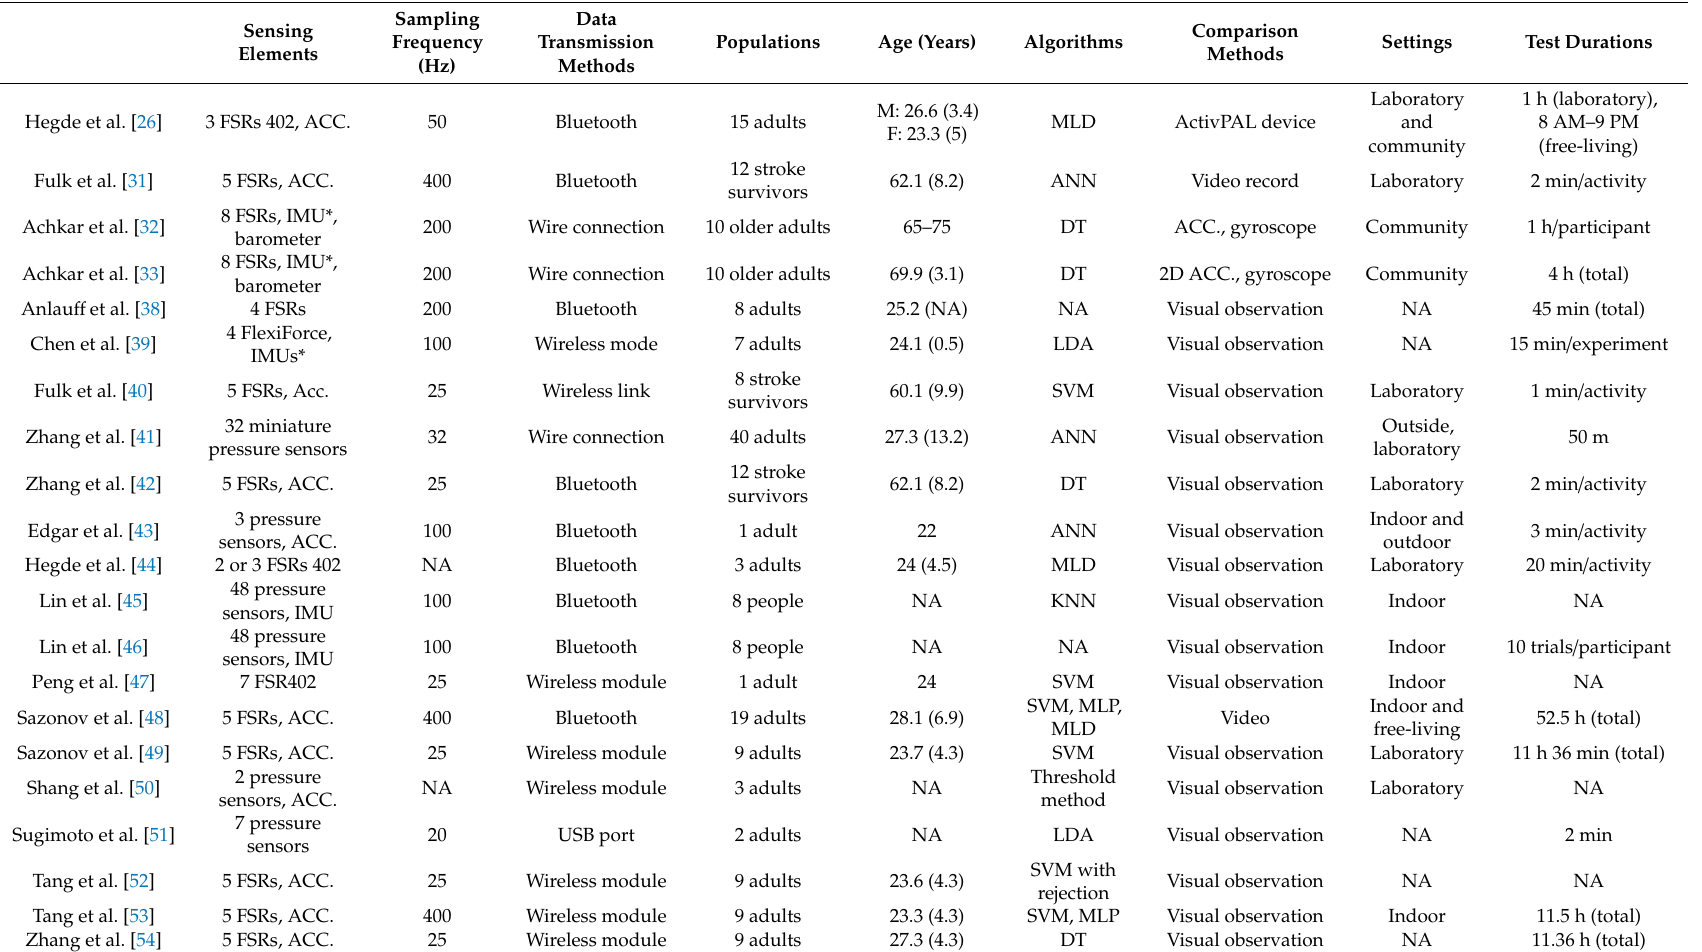
Table 2. Description of technical features of insoles for posture and activity recognition.